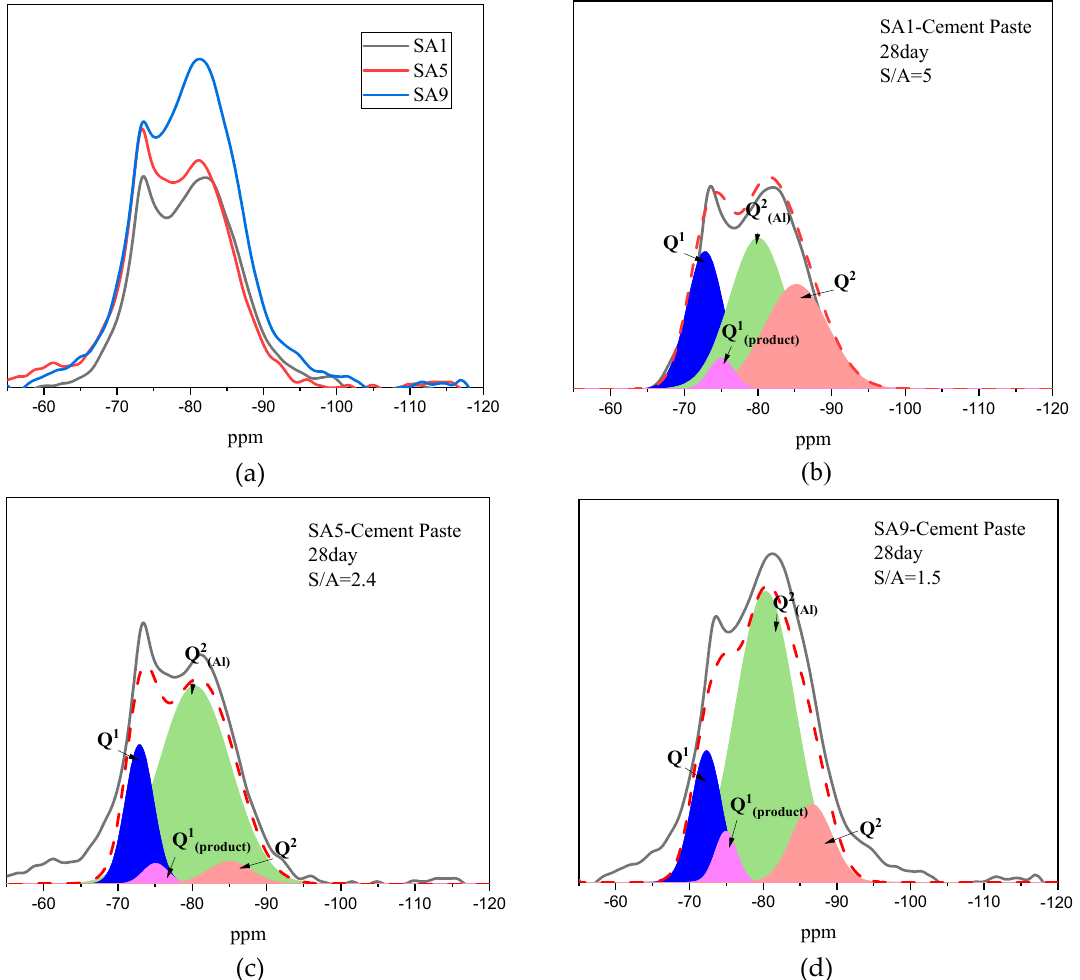
Figure 8. The evolution of the polymerization state of the silicon tetrahedron at a 3-day age: ( a ) stacking chart; ( b ) SA1; ( c ) SA5; ( d ) SA9.